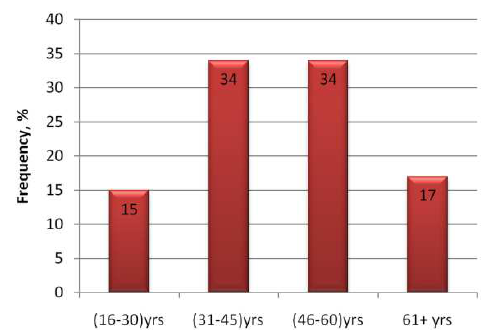
Fig. 5. Financing of farming ventures